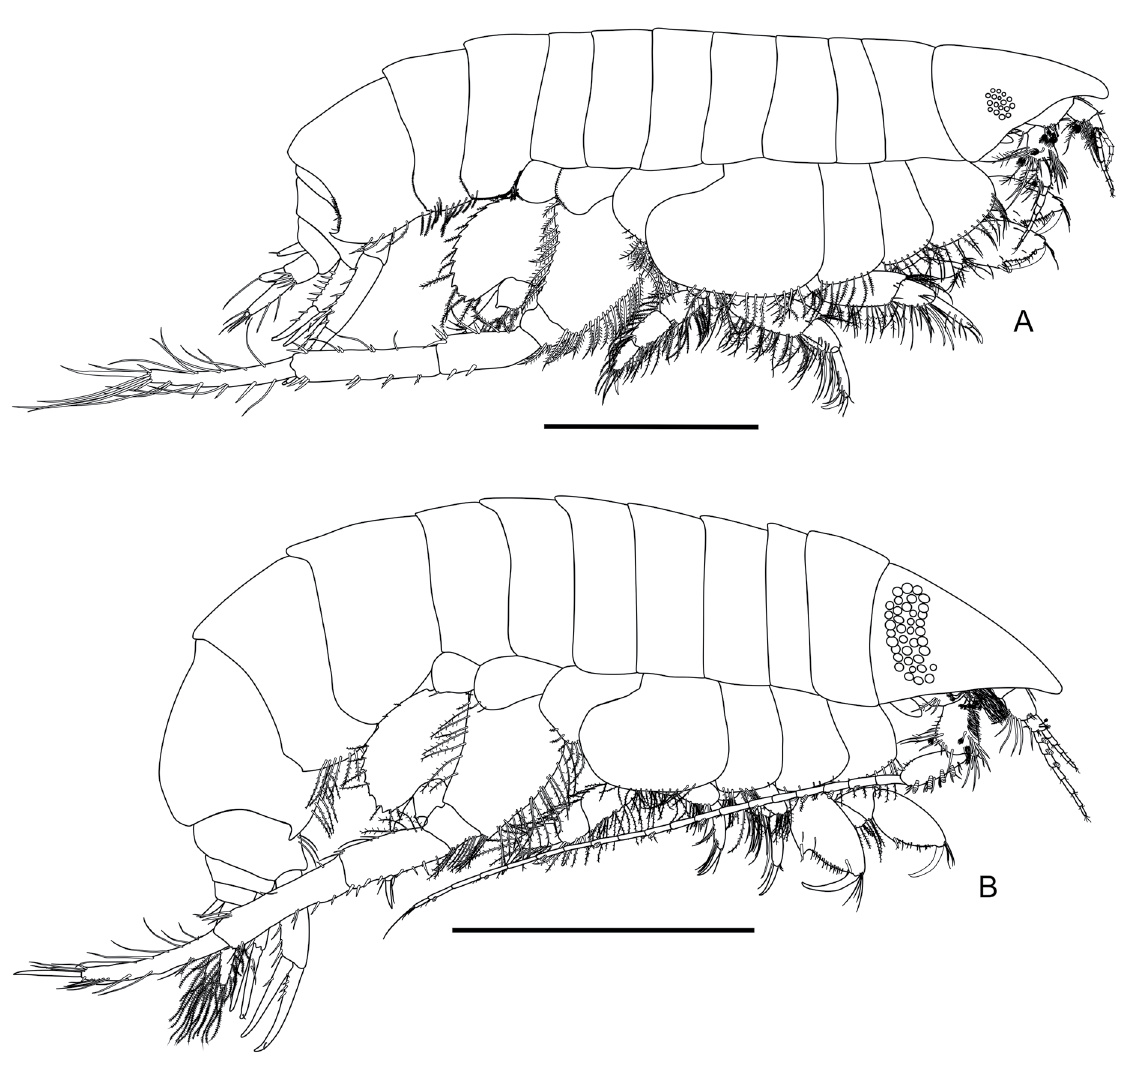
Fig. 1. Heterophoxus shoemakeri sp. nov., habitus. A . Holotype, ♀ (UERJ 433). B . Paratype, ♂ (UERJ 434). Scale bars = 1.0